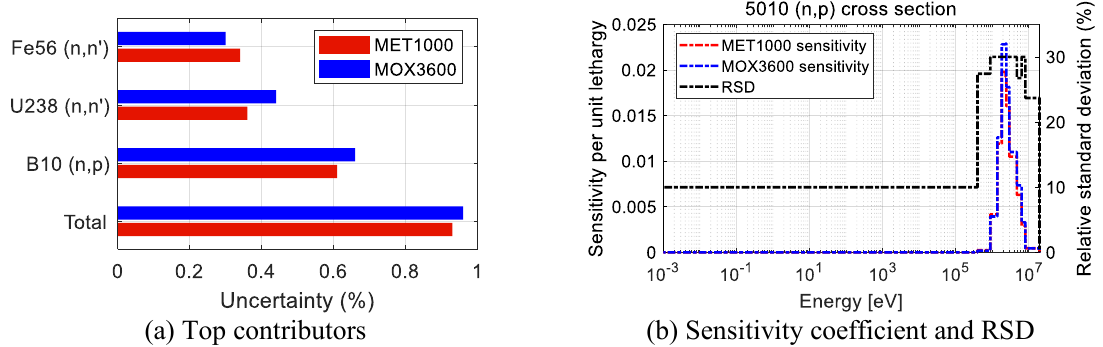
uncertainty 𝒂𝒃𝒔,𝟏𝒈